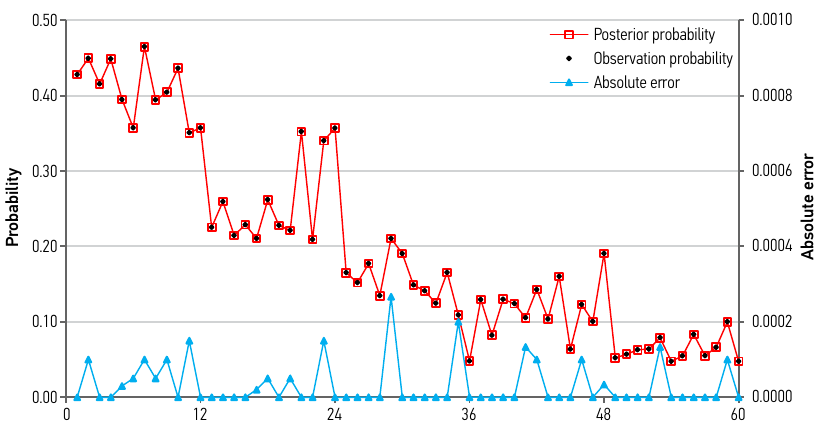
Fig. 4. Absolute error distributions of posterior probabilities at X intersection